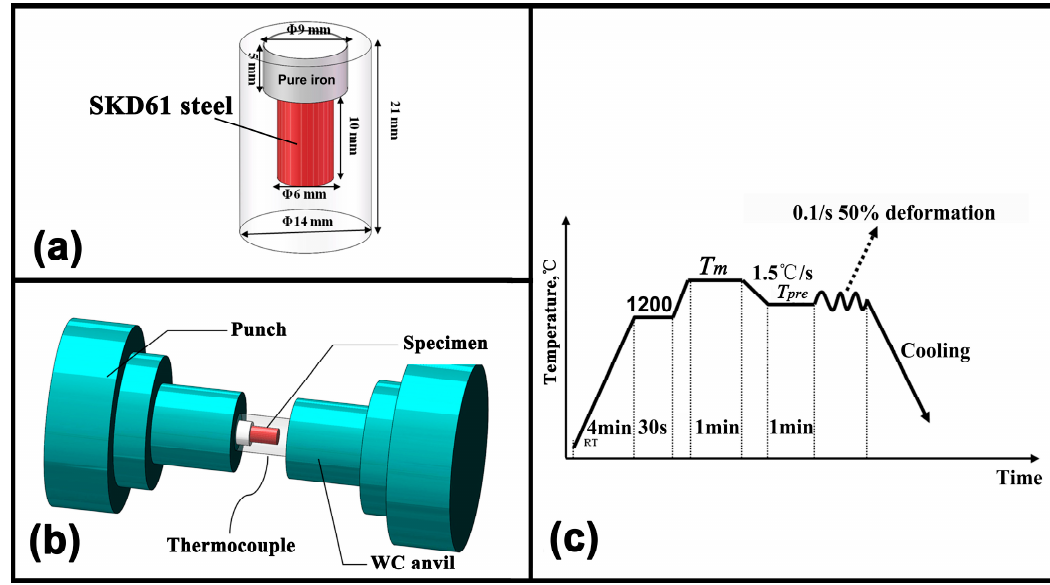
Figure 2. Schematic diagram of experiment setup in semi-solid compression tests ( a , b ) and process program ( c ). RT: room temperature; T m : liquidus temperature; and T pre : predetermined temperature.